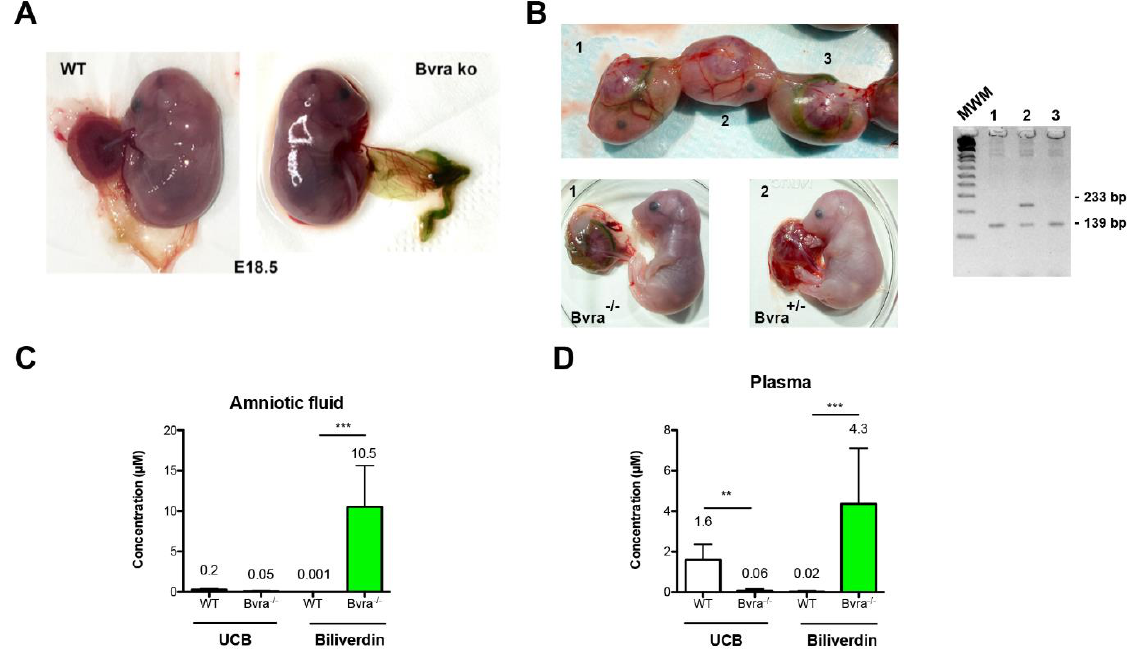
Figure 2. Bvra deficiency results in biliverdin accumulation in amniotic fluid and embryos. ( A ) Biliverdin accumulates in Bvra −/− embryos at embryonic day 18.5 (E18.5) but not in age-matched WT embryos; ( B ) dated breeding between Blvra +/− female and Blvra −/− males was performed. Embryos and placentas were analyzed at embryonic day 18.5 (E18.5). Resulting embryos were Bvra +/− (embryo 1 and 3) or Bvra −/− (embryo 2). Only Bvra −/− embryos accumulated biliverdin in the yolk sac, indicating that biliverdin did not cross the placental barrier effectively. Genotype of the embryos was verified by genomic PCR. ( C , D ) Bilirubin and biliverdin levels in amniotic fluid and in plasma. Data represent the mean ± SD. ( n = 9–11) for each genotype. Statistical analyses were performed by the Student’s t -test (**, p ≤ 0.01; ***, p ≤ 0.001).